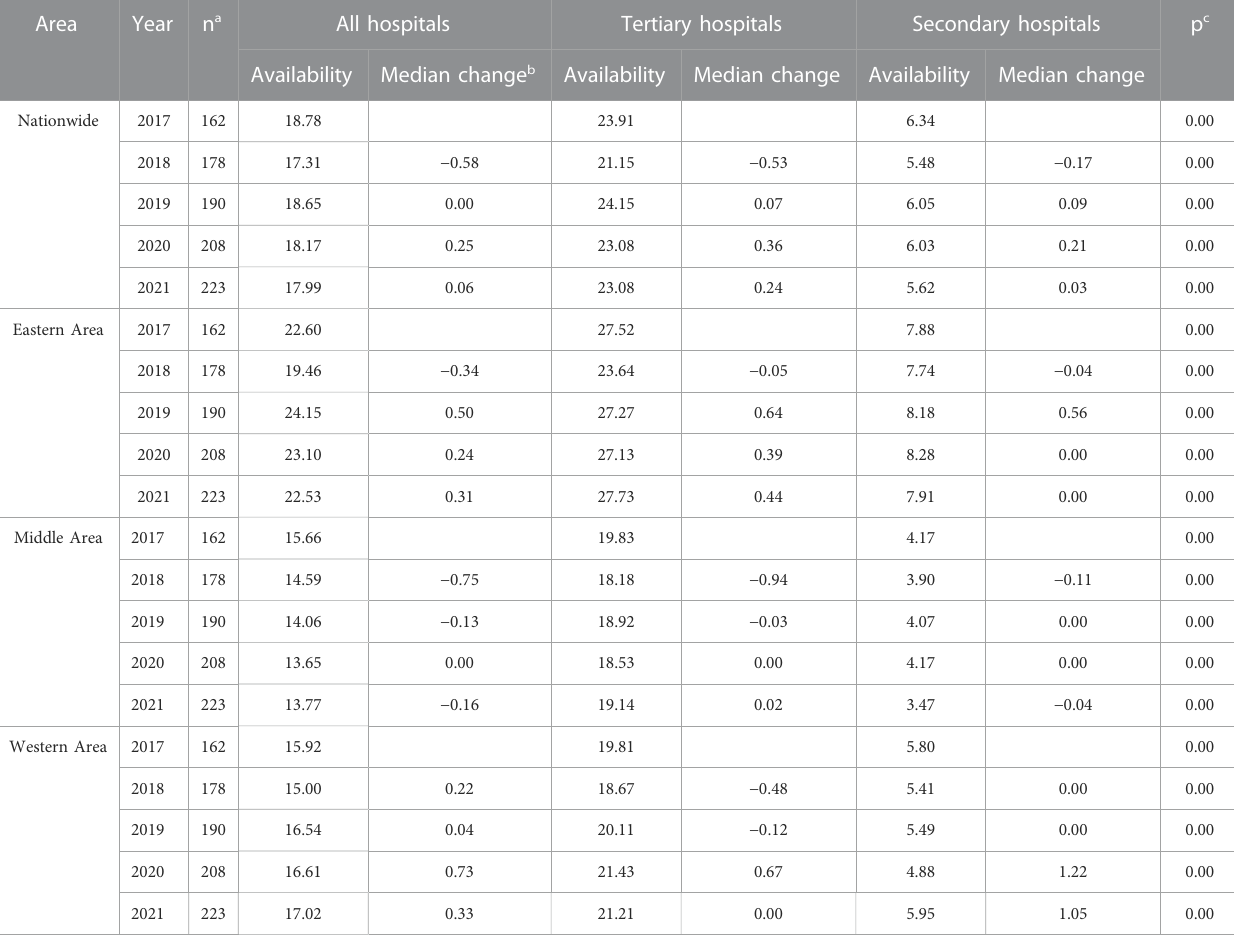
TABLE 1 Median availability of orphan drugs in hospitals in China from 2017 to 2021 (%).